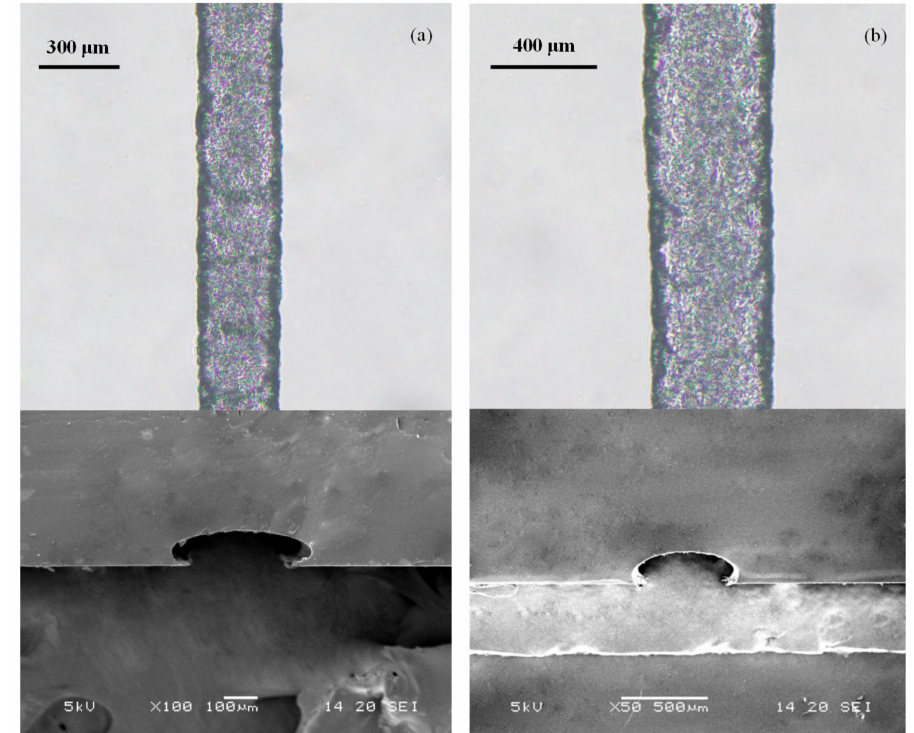
Figure 11. SEM photos of PDMS microchannels replicated using para ffi n wax molds with di ff erent widths and heights: ( a ) the microchannel width was 270 µ m and the height was 105 µ m and ( b ) the microchannel width was 440 µ m and the height was 180 µ m.